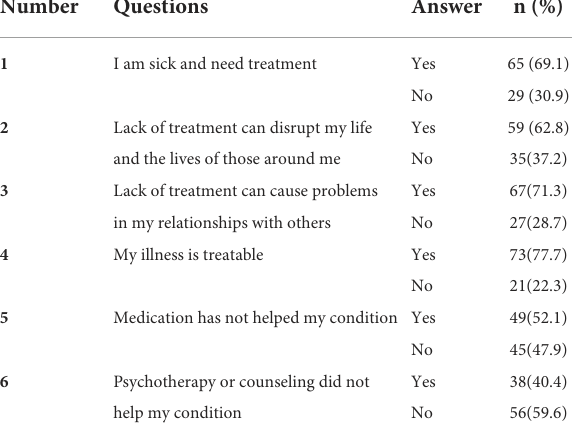
TABLE 2 Insight and attitude toward treatment (First part of the questionnaire).